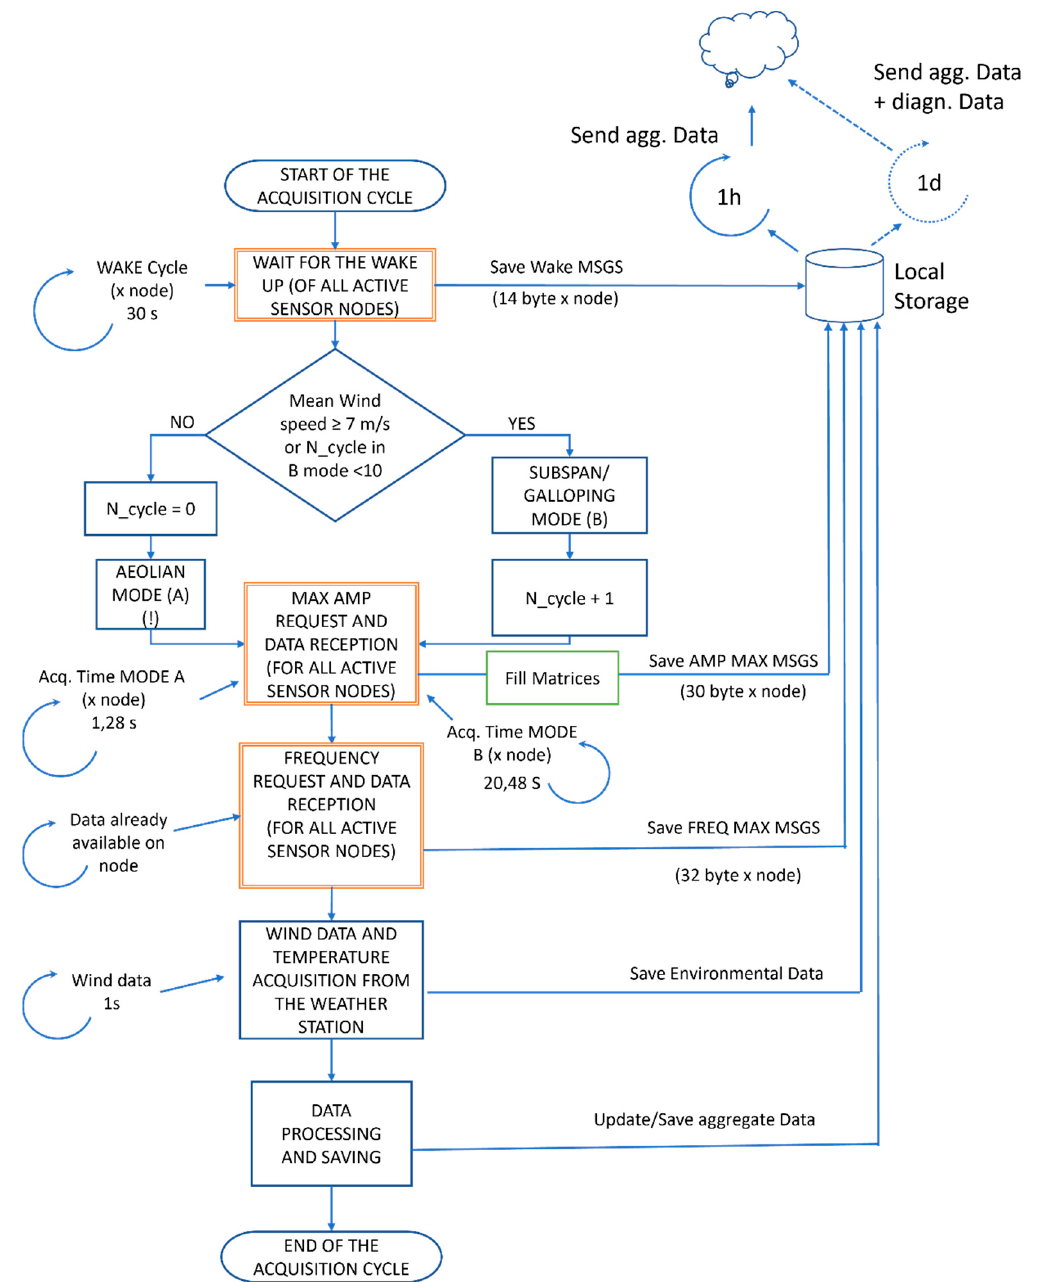
Figure 11. High-level algorithm flowchart.